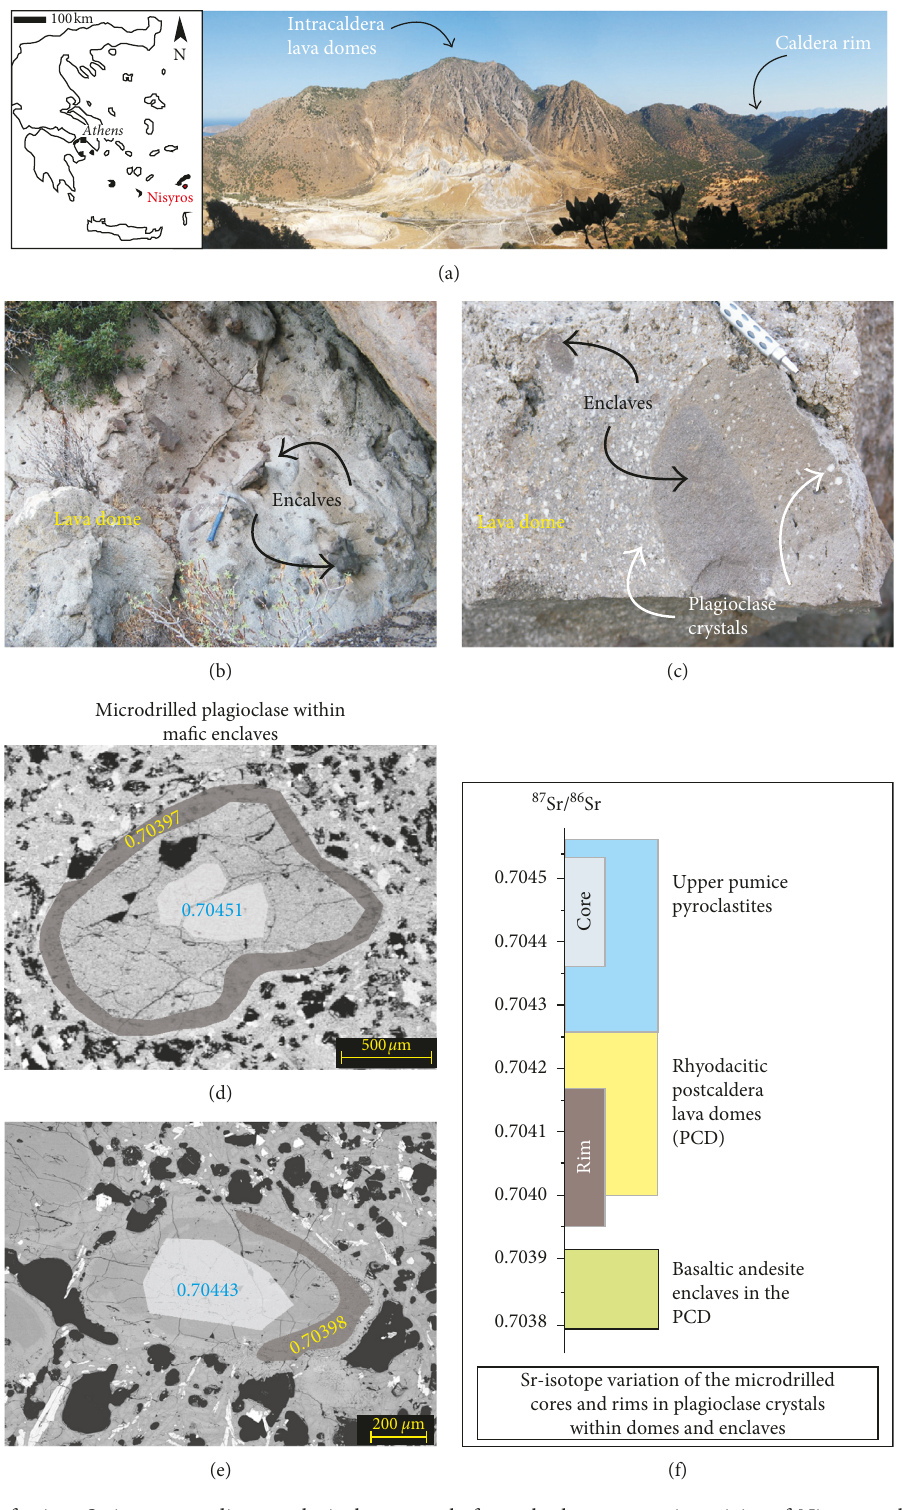
Figure 7: Results of micro-Sr isotope studies on plagioclase crystals from the last magmatic activity of Nisyros volcano (Greece). (a) Landscape view of the Nisyros caldera and its lava domes outpoured during the final magmatic activity of the volcano; (b) image of a lava dome outcrop rich in magmatic enclaves. Notably, the enclaves occurs as well-defined body with rounded and smooth surfaces; (c) specific image of a lava dome and enclave, both rich in large plagioclase crystals; (d and e) back-scattered electron microscope images of two representative plagioclase crystals selected for micro-Sr investigation with microdrill. The shaded areas represent the crystal zones drilled for Sr-isotope analyses, both on cores and rims; (f) 87 Sr/ 86 Sr variation of the drilled cores and rims compared to the range of 87 Sr/ 86 Sr of host whole rock (domes and enclaves) and upper pumice whole